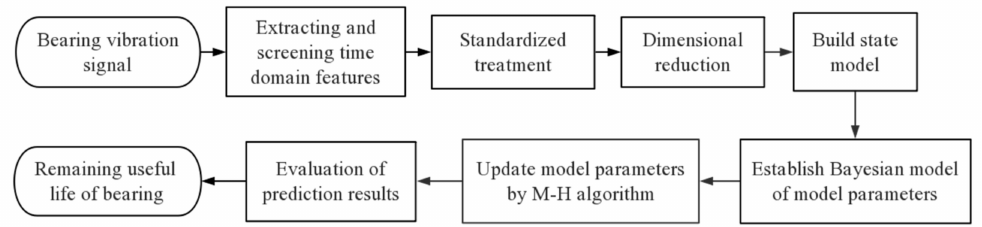
Figure 1. Flowchart of proposed bearing remaining useful life (RUL) prediction